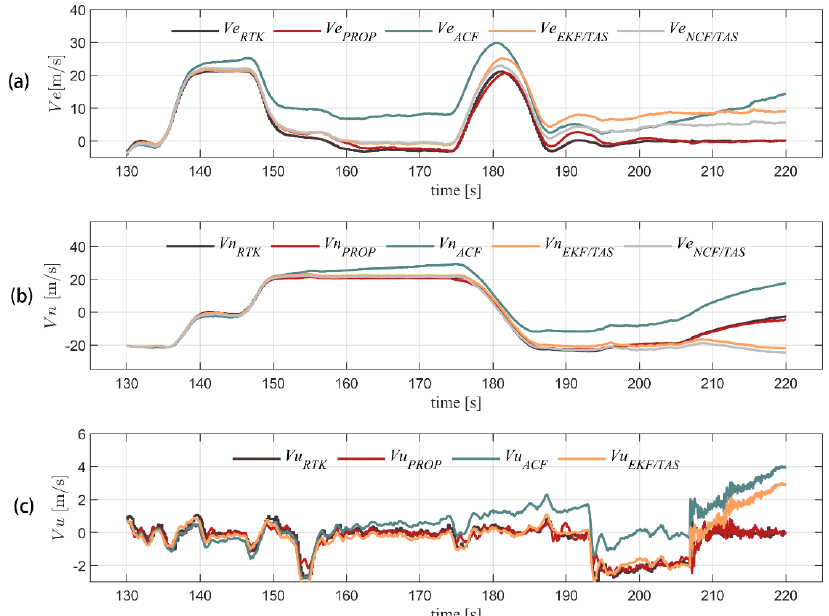
Figure 8. Three-axis velocity solution of five algorithms in flight is shown for east, north, and up velocity (from ( a – c ), respectively). In order to find difference of horizontal position, NCF/TAS and what we proposed use the same height model, so the curve of NCF/TAS is not drawn in the bottom figure.